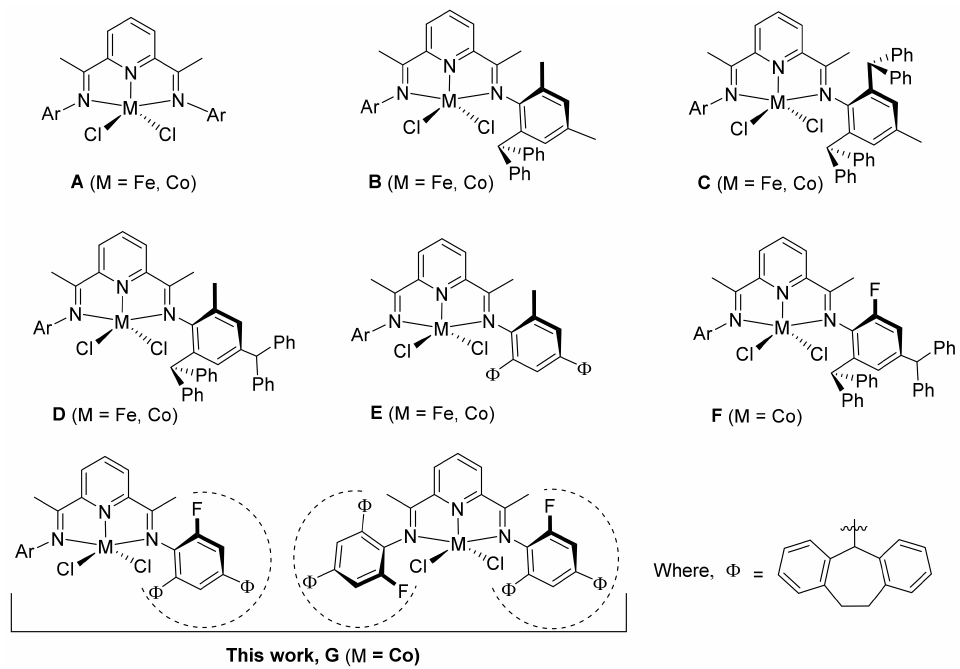
Figure 1. Structural modifications to the ligand framework in 2,6-bis(arylimino)pyridine-iron(II) and -cobalt(II) chloride complexes, A – F , including the target of this work, G